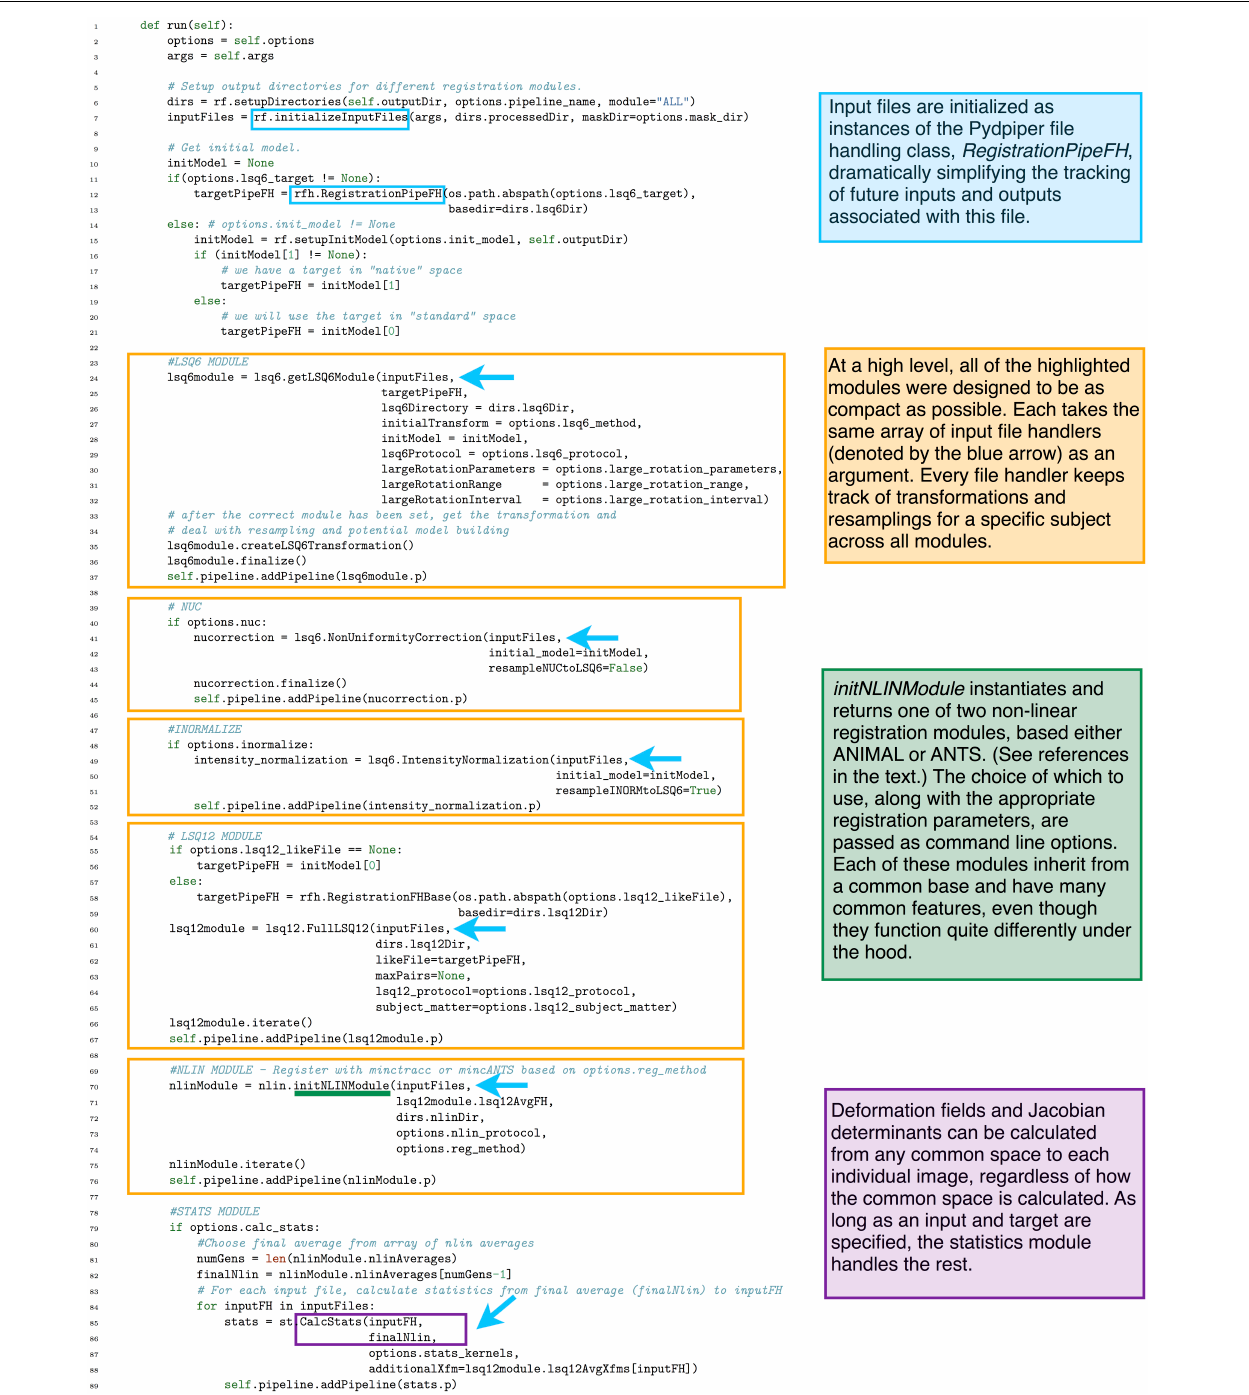
FIGURE 9 | run() function in the iterative group-wise registration application. This piece of code illustrates how an extremely complex pipeline can be built up from smaller modules making it simple to read at the application level.